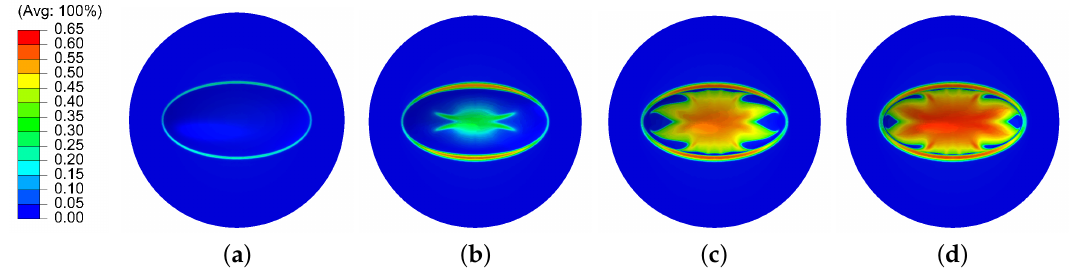
Figure 8. Viscoplastic strain contour plot on the deformed polycarbonate sheet at gas pressure levels of ( a ) 1.0 MPa, ( b ) 1.5 MPa, ( c ) 2.0 MPa, and ( d ) 3.0